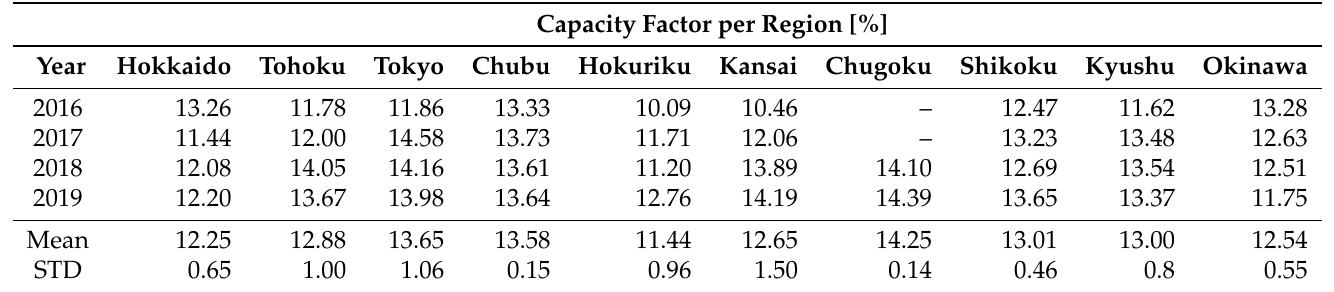
Table 8. Annual load factor [%] by region between 2016 and 2019. Capacity Factor per Region